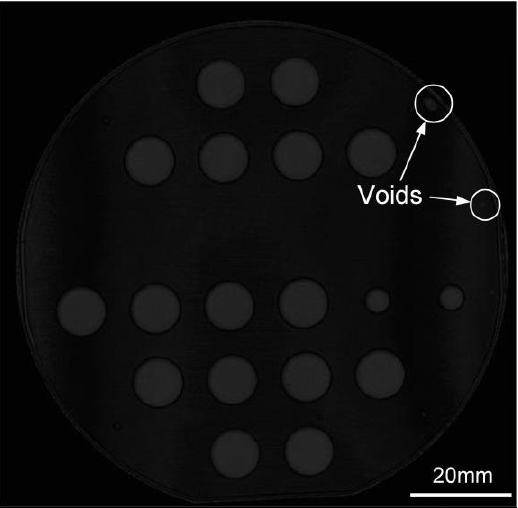
Figure 4. Scanning acoustic microscopy (SAM) image of the bonded SiC wafer.